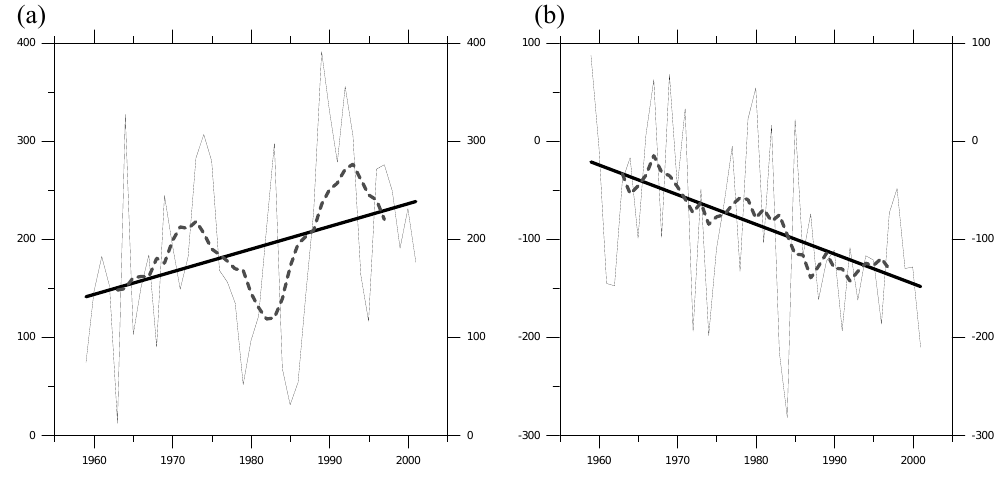
Fig. 9. Same as Fig. 8 over Central Europe (50 ◦ N, 10 ◦ E) (a) and Labrador (b) at for